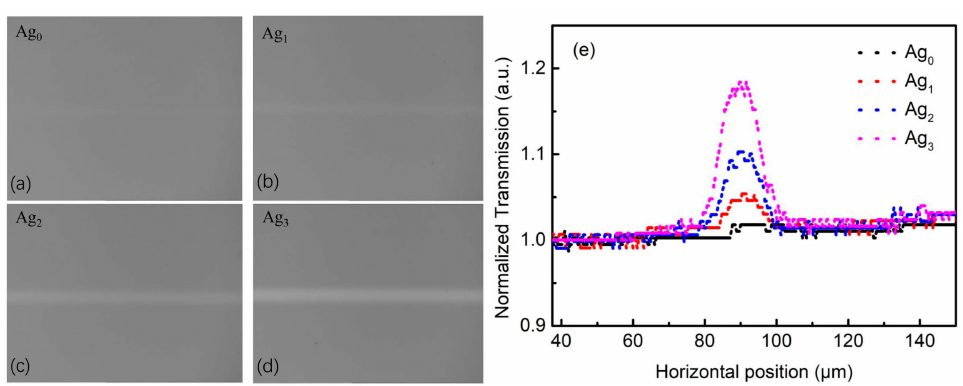
Figure 3. Optic microscopic images of the ( a ) Ag 0 ( b ) Ag 1 ( c ) Ag 2 ( d ) Ag 3 thin films after laser irradiation at 25 mW. ( e ) Normalized transmittance of the irradiated